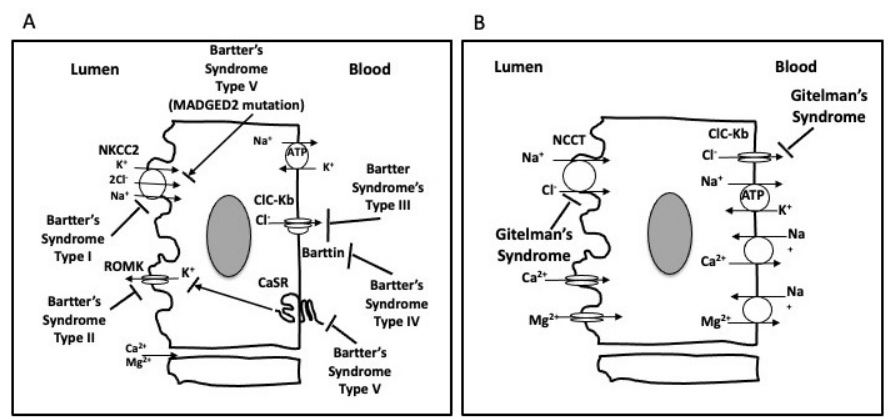
Figure 1. Transport pathways in the thick ascending limb of Henle’s loop depicting the five (I–V) types of Bartter’s syndrome (BS, A ). Transport pathways in the distal convoluted tubule depicting the abnormality of Gitelman’s syndrome (GS, B ).